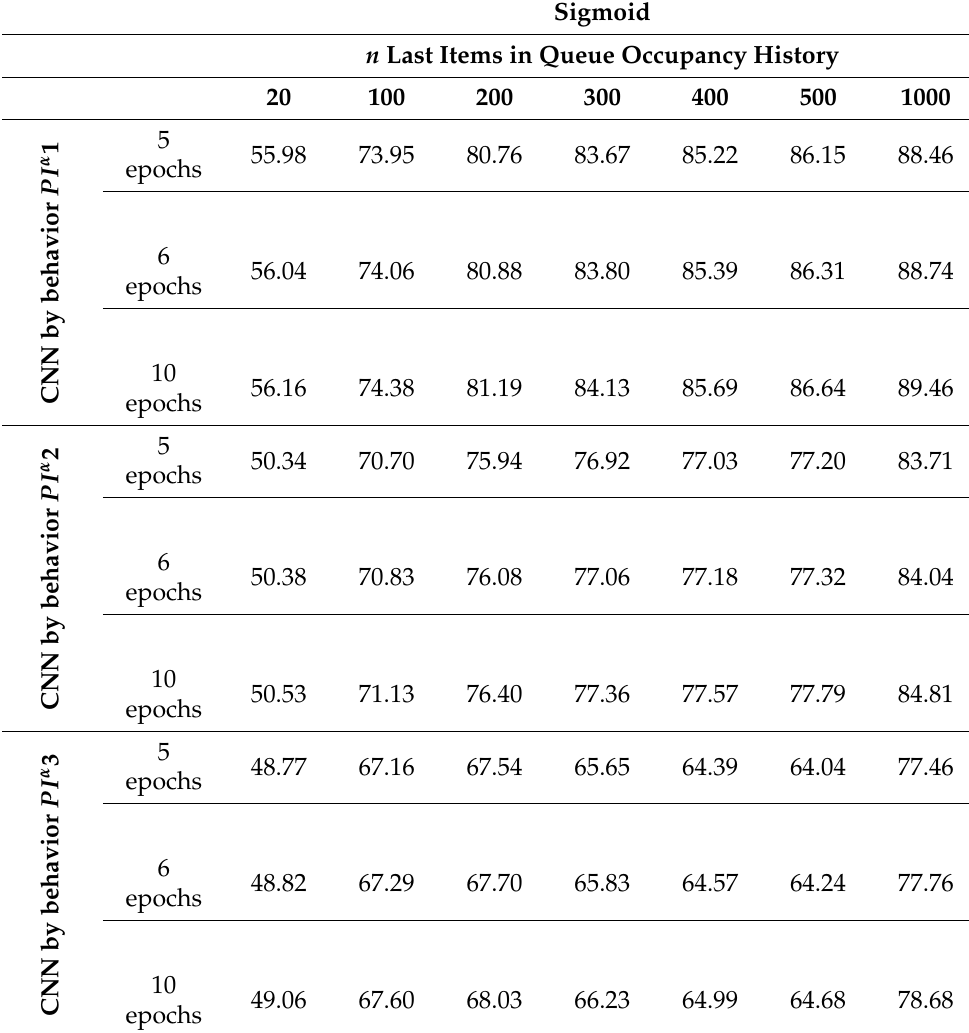
Table 4. The accuracy measurements for test data for a neural network model trained with data representing the behavior of PI α 1, PI α 2 and PI α 3 controllers, n last items in queue occupancy history taken into consideration (we used Sigmoid function as an activation function of the last